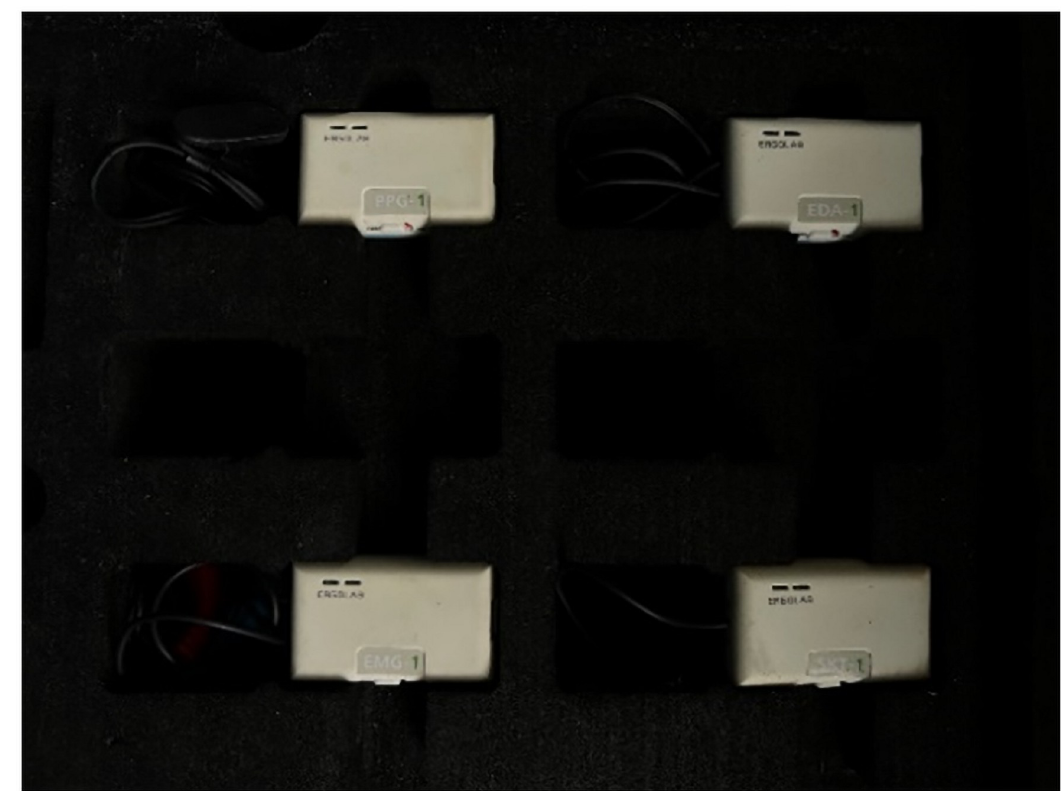
Fig 6. ErgoLAB physiological